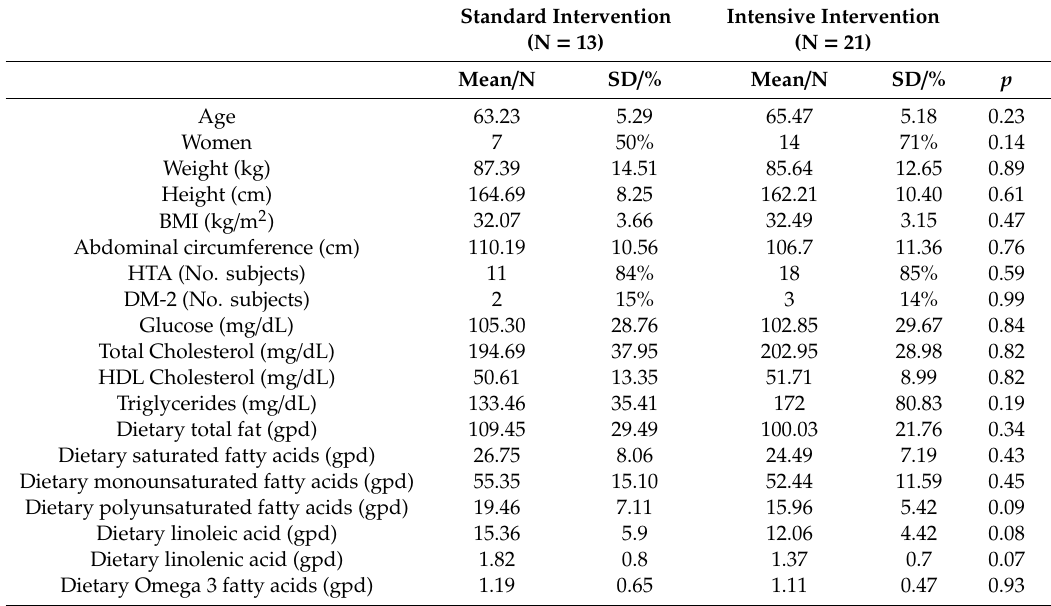
Table 1. Baseline anthropometrics and diet characteristics.